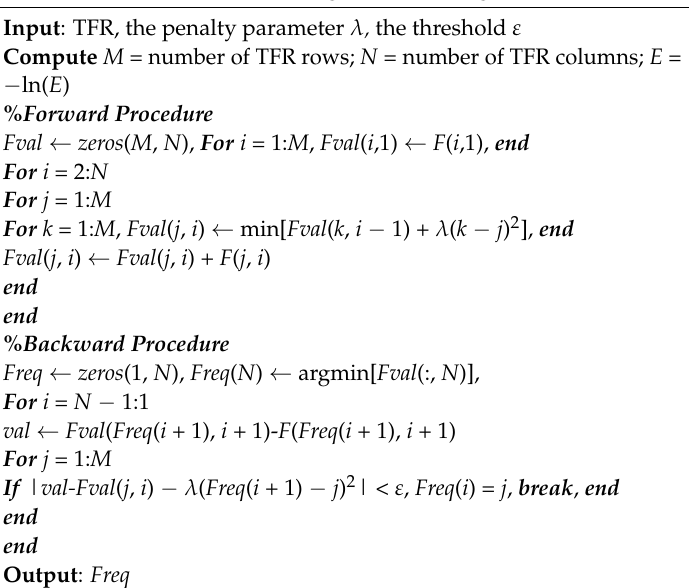
Algorithm 1. Pseudo-code of ridge extraction